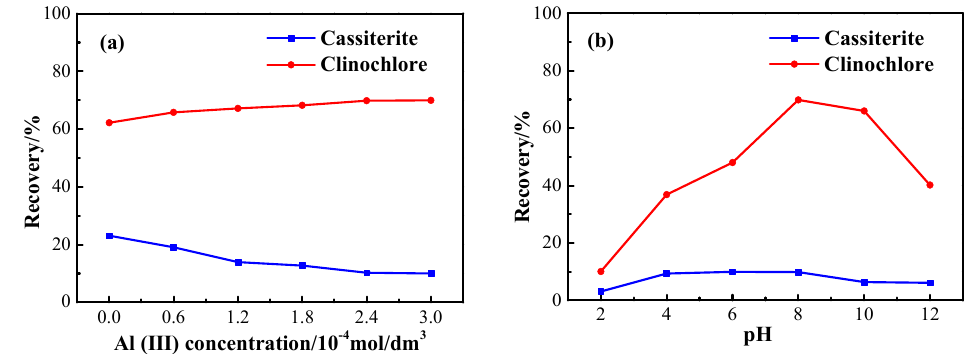
Figure 4. Effect of ( a ) Al (III) ions concentration (at pH 8.0) and ( b ) pH values (at Al (III) ions concentration of 2.4 × 10 −4 mol/dm 3 ) on floatability of cassiterite and clinochlore.